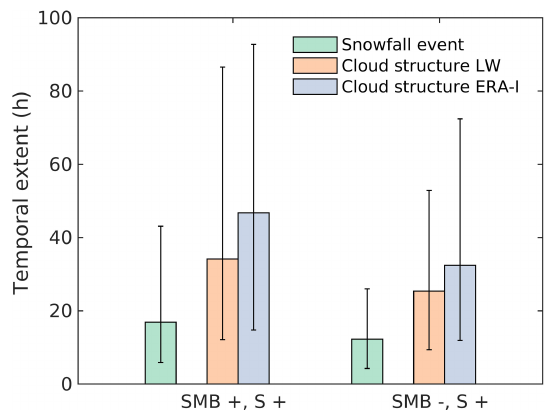
Figure 6. Duration (green) and the temporal extent of the cloud structure (red and blue) for snowfall events resulting in accumula- tion (SMB + , S + ) and ablation (SMB − , S + ) (hours). Columns denote the average value, while the error bars denote the 25th and 75th percentile based on all